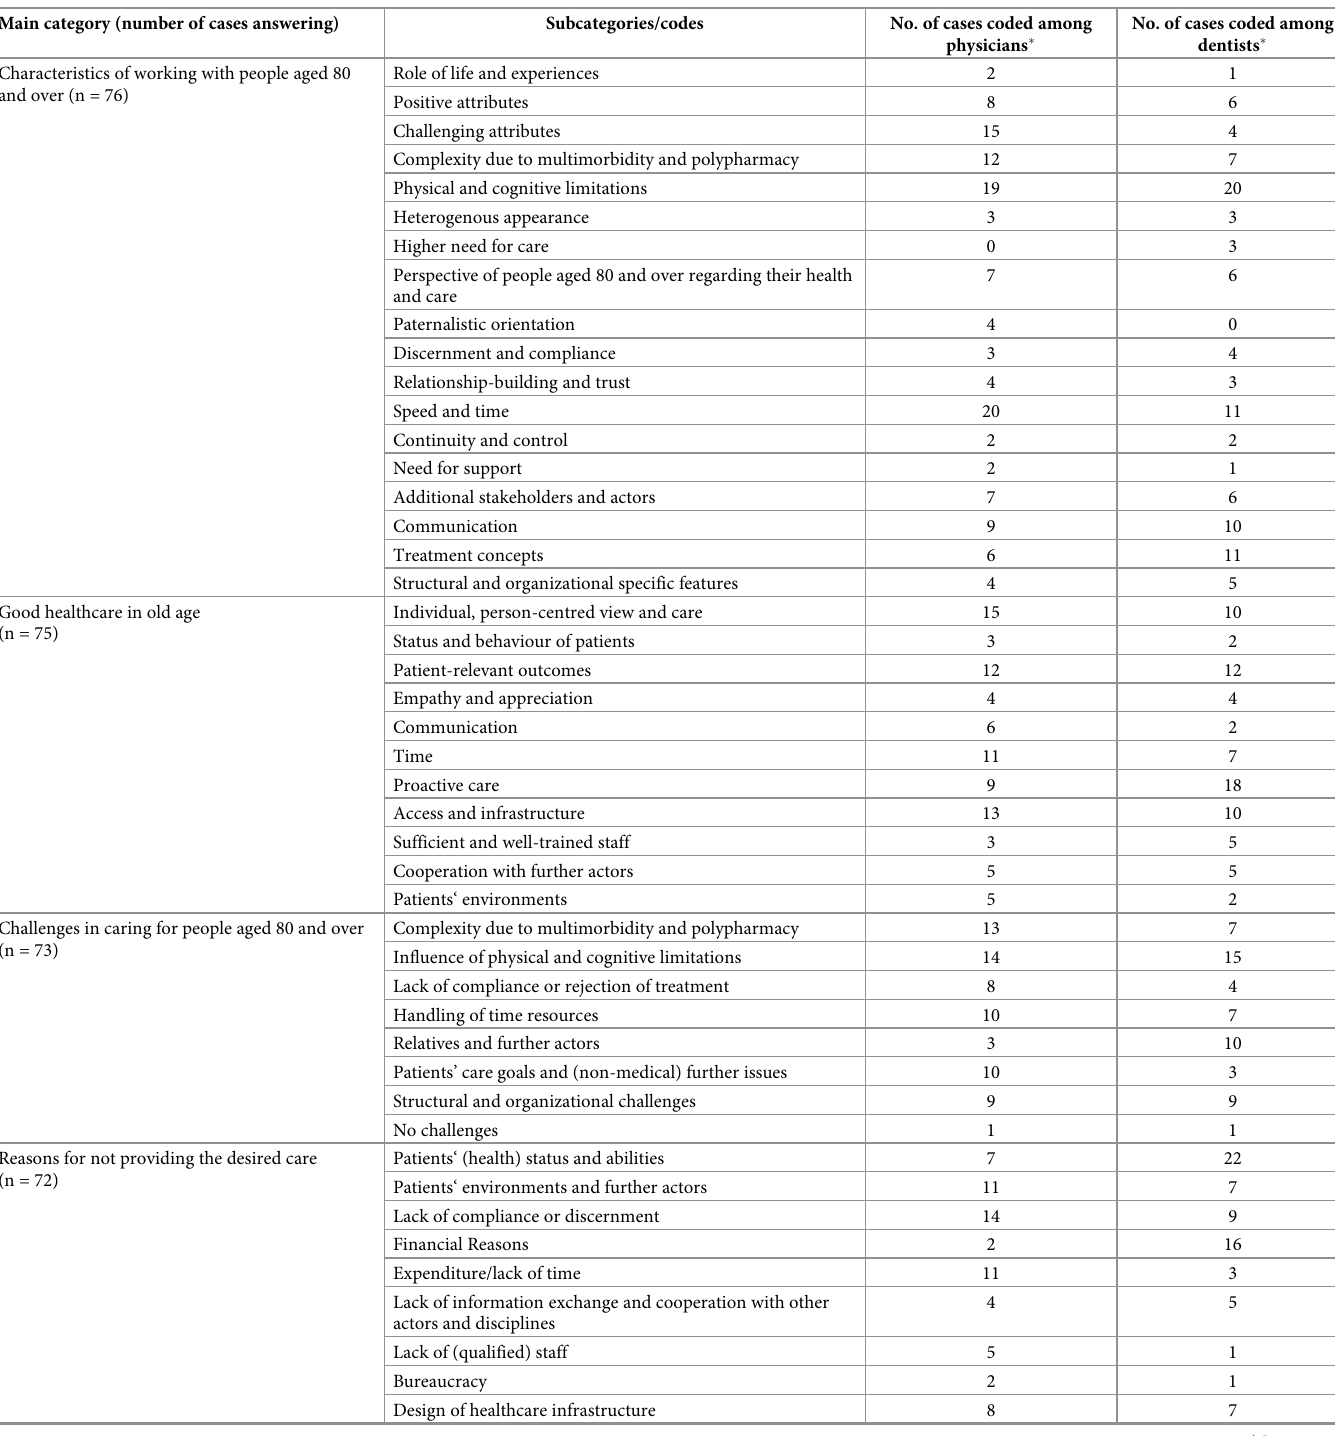
Table 3. Overview of descriptive codebook and code frequencies. Main category (number of cases